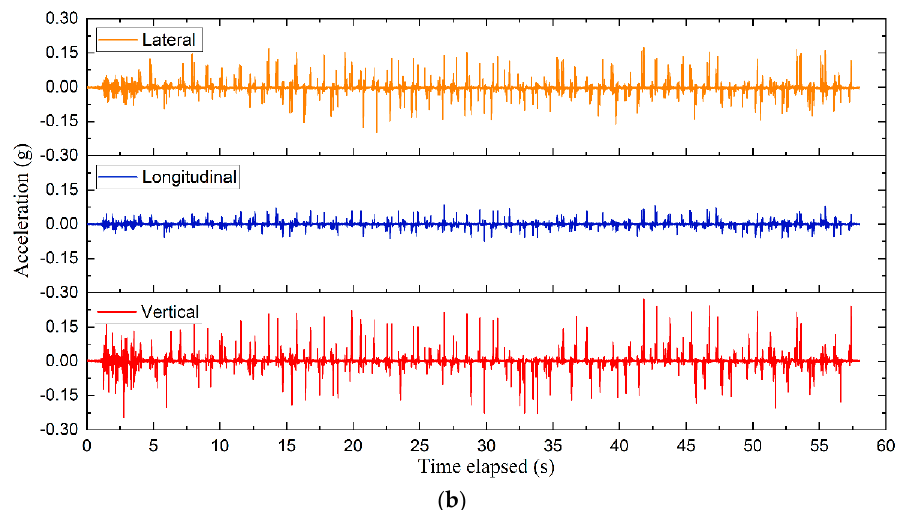
Figure 10. Comparison of the time-history acceleration data processed by ( a ) the IIR low-pass and ( b ) the FFT low-pass filtering methods.